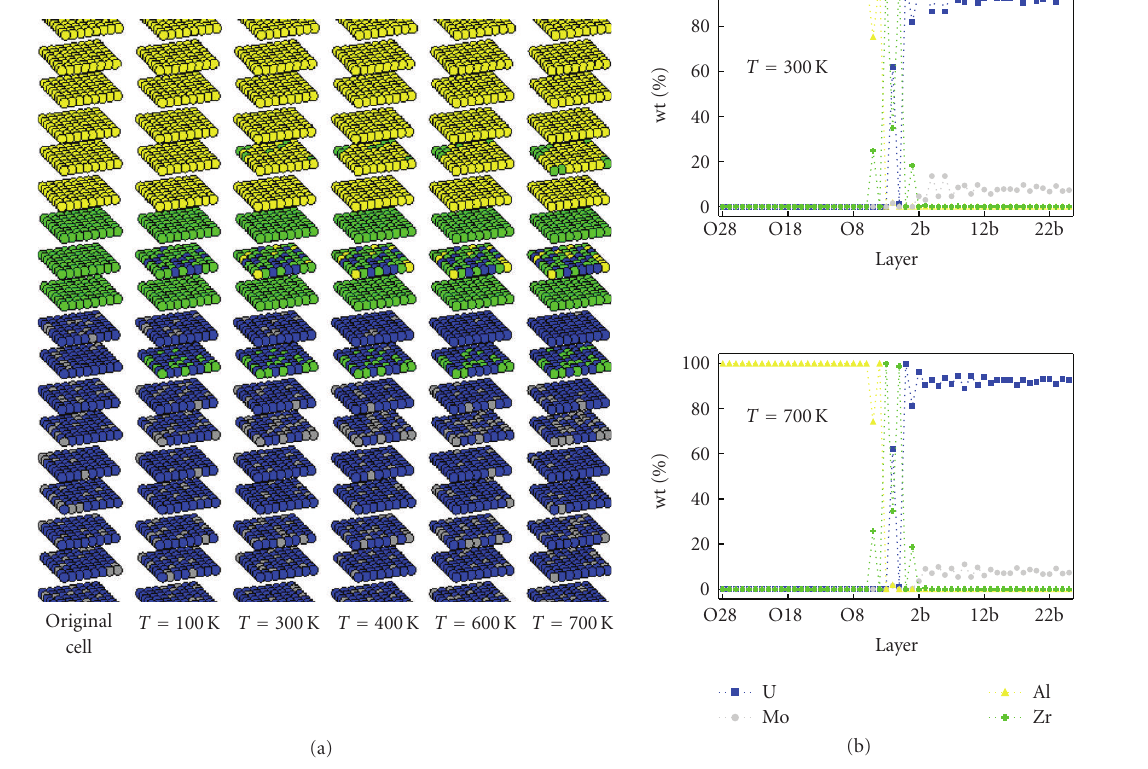
Figure 13: Intermediate states of a simulation of a computational cell with three C planes in the Al/U-7wt% Mo interface. U, Mo, Al, and C atoms (and profiles) are denoted in blue, grey, yellow, and green, respectively. The original location of the interface (at the onset of the simulation) corresponds to the label